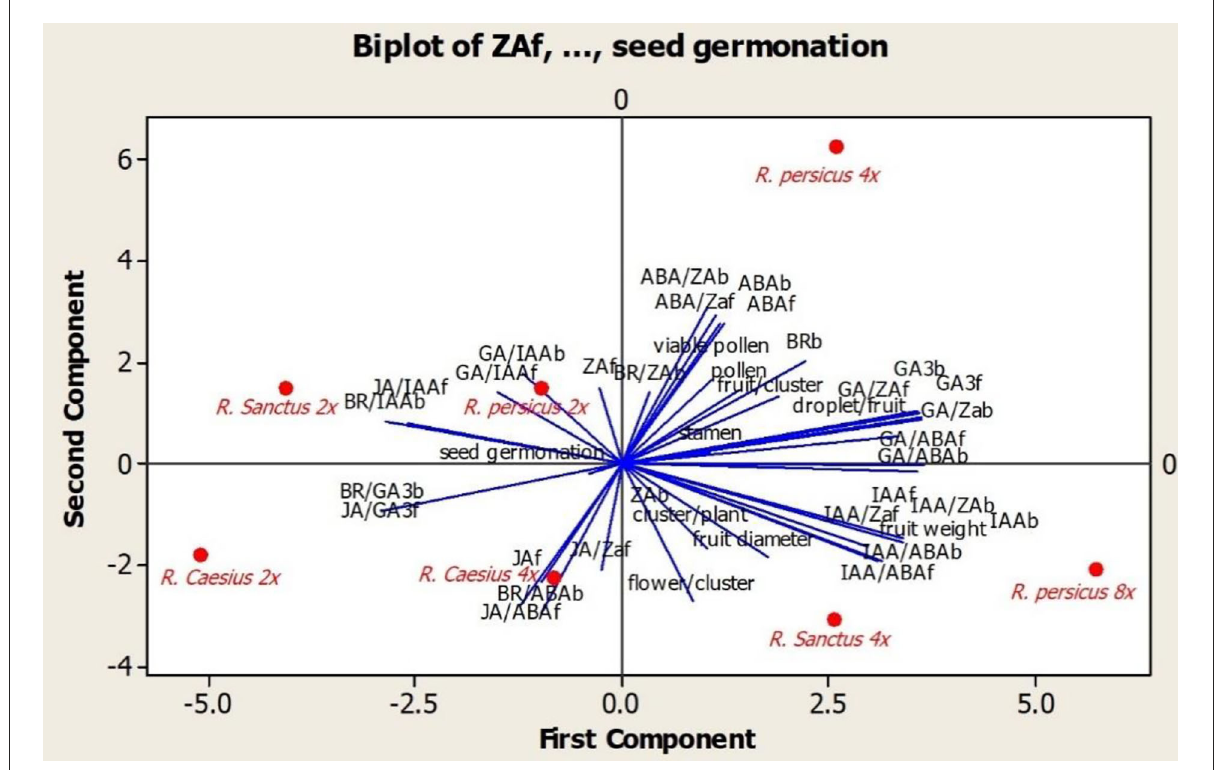
FIGURE7 Bi-plot generated based on first two components of the principal components analysis using all measured characteristics of studied Rubus